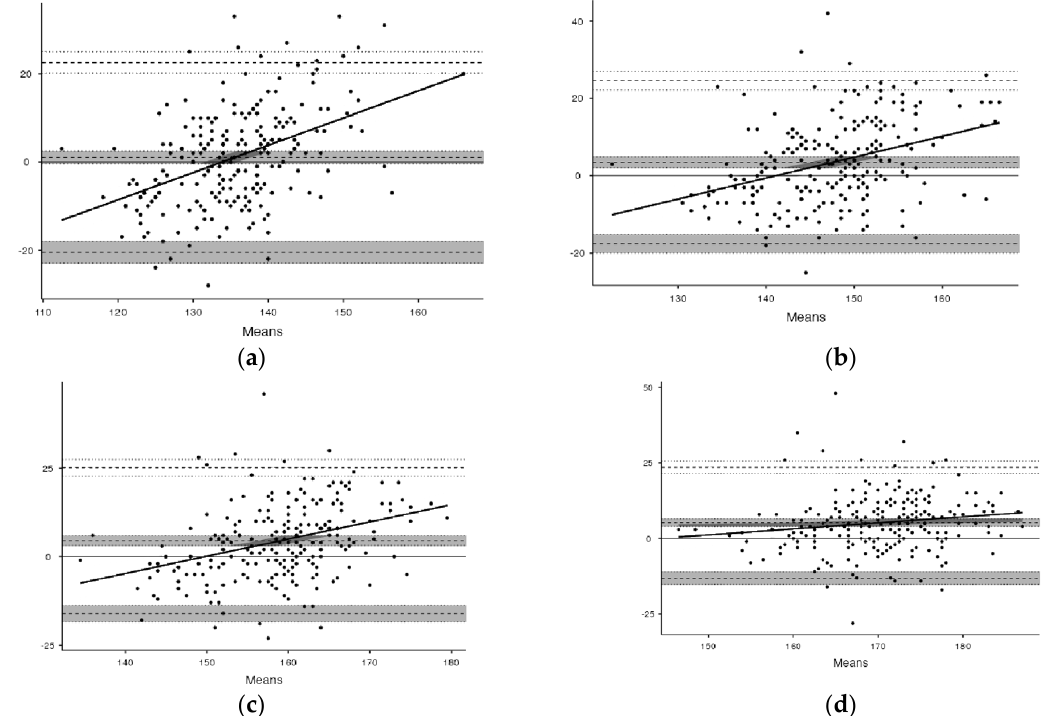
Figure 2. Analysis of Bland and Altman residual scores between HR/VO 2 and estimation equations for intensity of 50, 60, 70 and 80% VO 2peak for 197 healthy individuals of both sexes. ( a ) 50% of HC/VO 2peak . ( b ) 60% of HC/VO2peak. ( c ) 70% of HC/VO 2peak . ( d ) 80 of HC/VO 2peak .